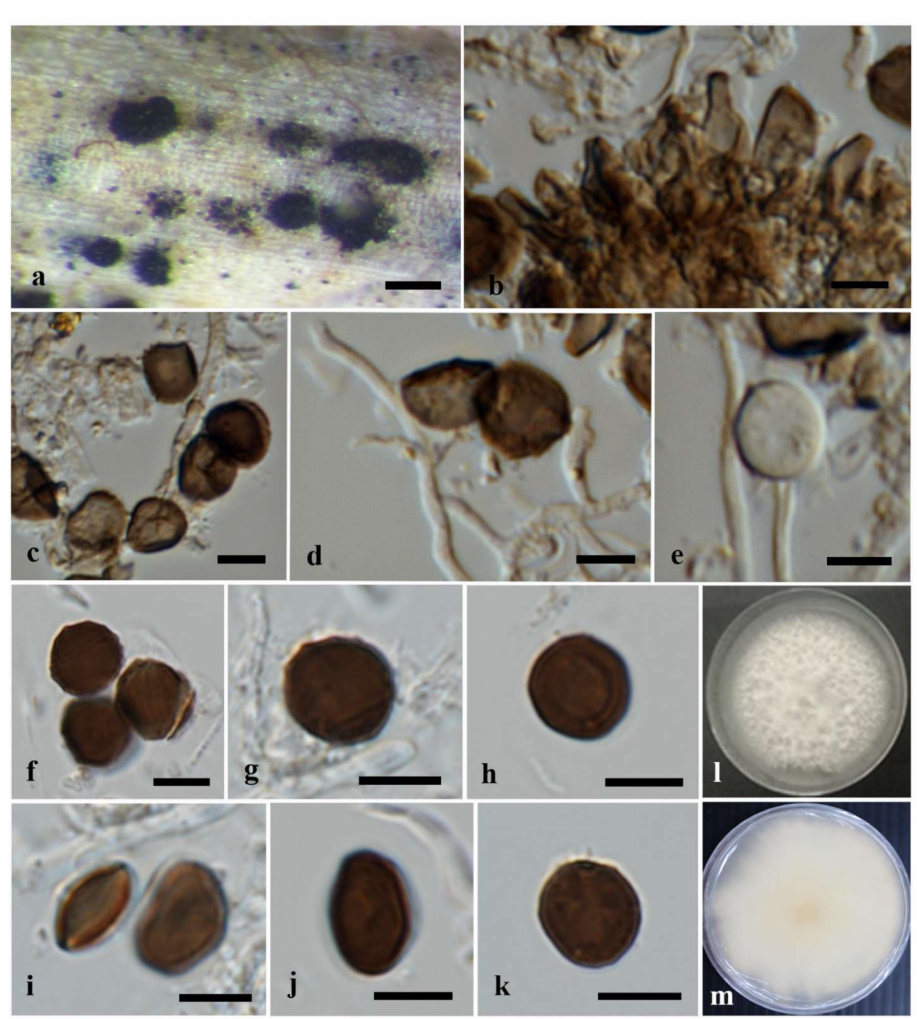
Figure 3. Apiospora mukdahanensis (MFLU 22-0104, holotype). ( a ) Conidiomata on host substrate. ( b ) Conidiophore mother cells. ( c – e ) Conidiophores, conidiogenous cells and conidia. ( f – k ) Conidia. ( l , m ) Colonies on PDA (( l ) from above, ( m ) from reverse). Scale bars: ( a ) = 200 µ m, ( b – k ) = 5 µ